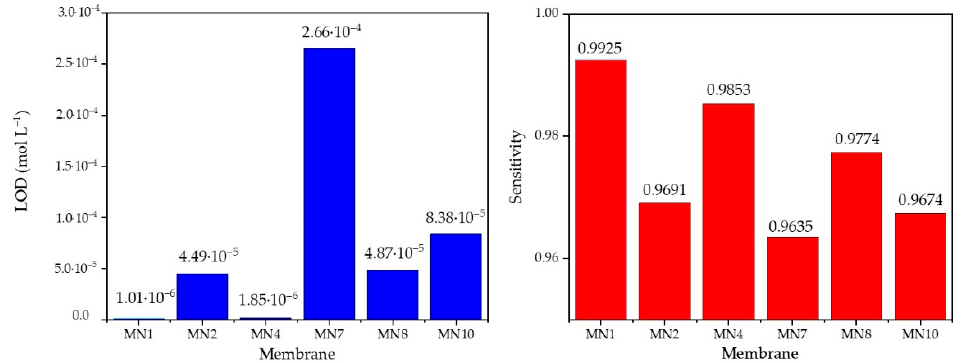
Figure 15. A comparative bar graph for LOD and sesnsitivity values fo MN1, MN2, MN4, MN7, MN8, and MN10 membranes.